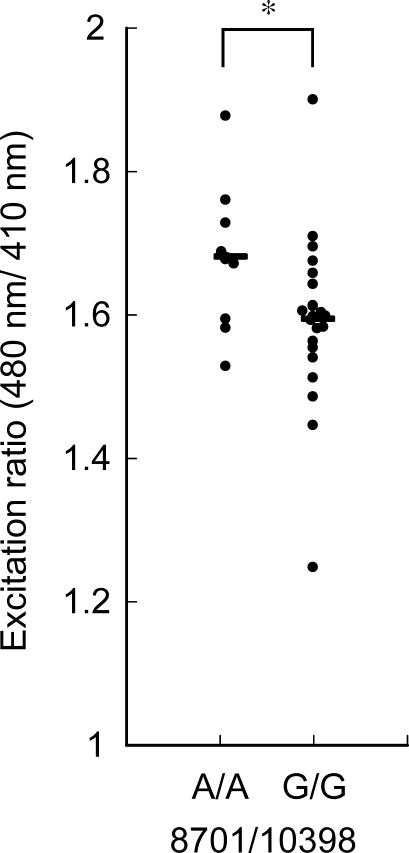
Effects of 10398A/G on Basal Fluorescence Ratios of Mitochondria-Targeted RPDifferences between the basal fluorescence ratios in 10398A and 10398G cybrids are shown. All cybrids with 8701A have 10398A (left). While most cybrids with 8701G had 10398G (right), two cybrids had 8701A and 10398G (the data of these two cybrids were 1.52 and 1.77). For each cybrid, data taken from 11–42 cells (average, 26 cells) were averaged. The y axis shows the ratio of the 525 nm fluorescence at 480 nm to that at 410 nm. Horizontal bars indicate the mean values for each type of cybrid. *p < 0.05 (Mann-Whitney U test).